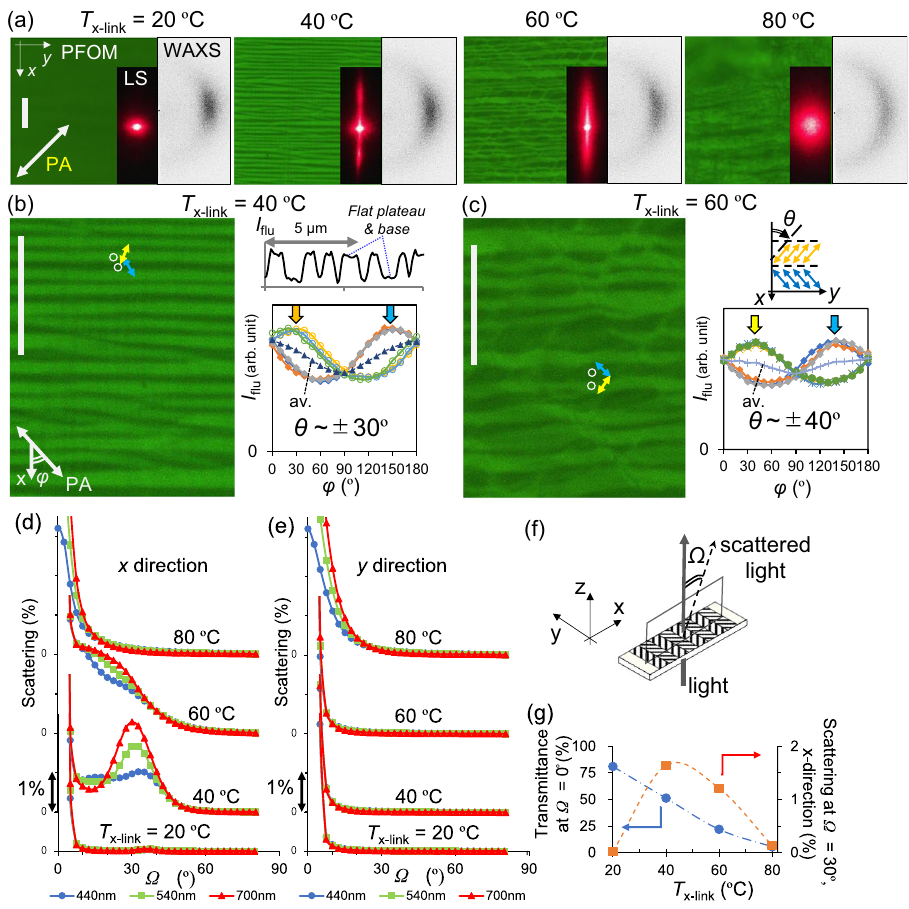
Fig. 4 LCEs with stabilized buckled director patterns. a Room-temperature PFOM, LS, and WAXS patterns of LCEs prepared using different crosslink temperatures ( T x-link ). Analysis of directors at LCE surfaces fabricated at b T x-link = 40 °C and c 60 °C. The typical intensity pro fi le (in b ), magni fi ed PFOM images, and the polarized fl uorescence intensity ( I fl u ) at speci fi c locations as a function of polarizer angle ( φ ) are shown (scale bar: 10 μ m). The white circles indicate the typical measurement positions for the φ – I fl u plots (details provided in the main text). The tilting angle ( θ ) can be estimated from the peaks of the φ – I fl u plots. Angle-dependent scattering intensities of LCEs in the d x- and e y -directions at different wavelengths (440, 540, and 700 nm). Each curve is vertically shifted for visibility (note each zero point). The sample crosslinked at 40 °C, in particular, exhibited pearlescence with iridescence. f Experimental setup for the scattering intensity measurements. g Transmittance at Ω = 0° and 30° in the x -direction plotted against T x-link